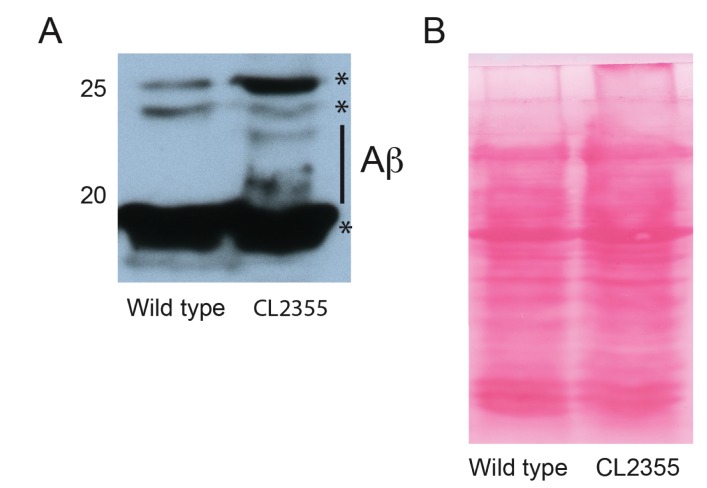
Western analysis of pan-neuronal expression of Abeta1-42 in C. elegans.(A) Representative western blot indicating Abeta1-42 peptide accumulation in the pan-neuronal Abeta1-42 expressing strain CL2355. * indicate non specific bands as observed in wild type animals. (B) Ponceau C staining of western blot shown in (A) indicating equal loading.10.7554/eLife.33052.016Figure 5—figure supplement 1—source data 1.Raw data for Figure 5—figure supplement 1.